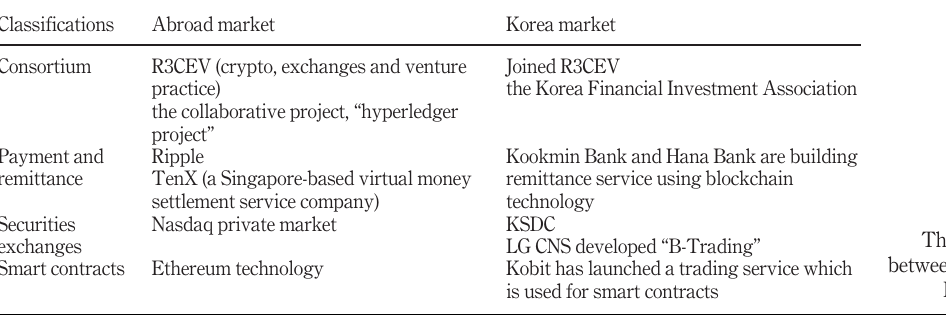
Table II. The comparison between abroad and Korea